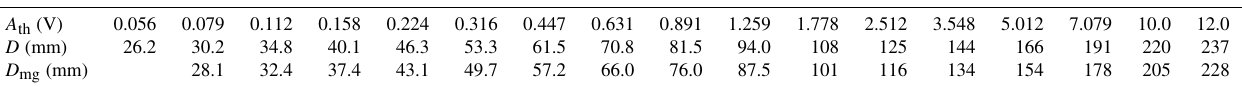
Table 2. Threshold values of the signal amplitude A used for the impulse count of the amplitude histograms at the Fischbach and Ruetz. To estimate a corresponding particle size D , an empirical relation from Wyss et al. (2016c) was used. D mg is the geometric mean size of each particle